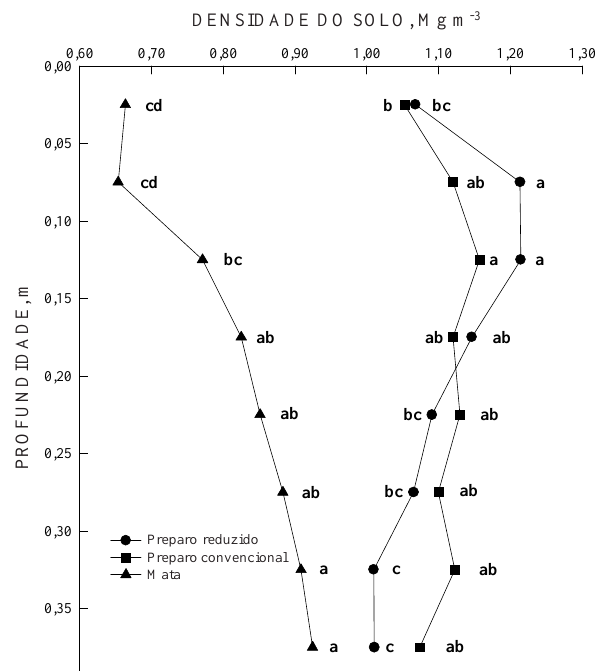
Figura 1. Densidade do solo no sistema de preparo reduzido, preparo convencional e na mata, na profundidade de 0–0,40 m (janeiro de